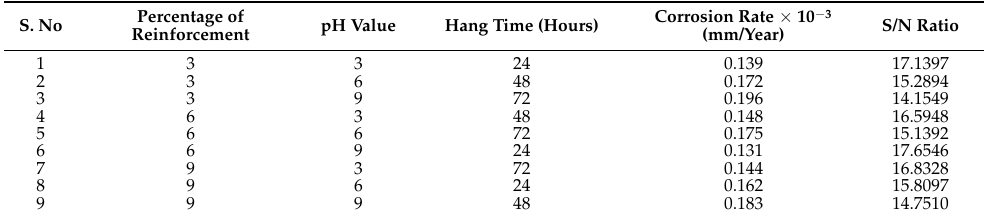
Table 14. Summary of corrosion